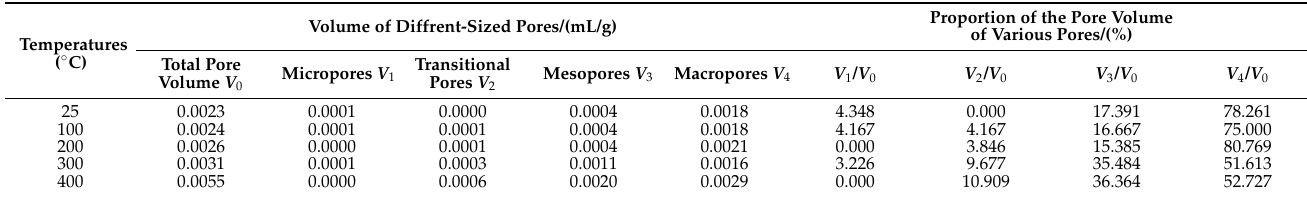
Table 3. Pore volume of granite at different temperatures.